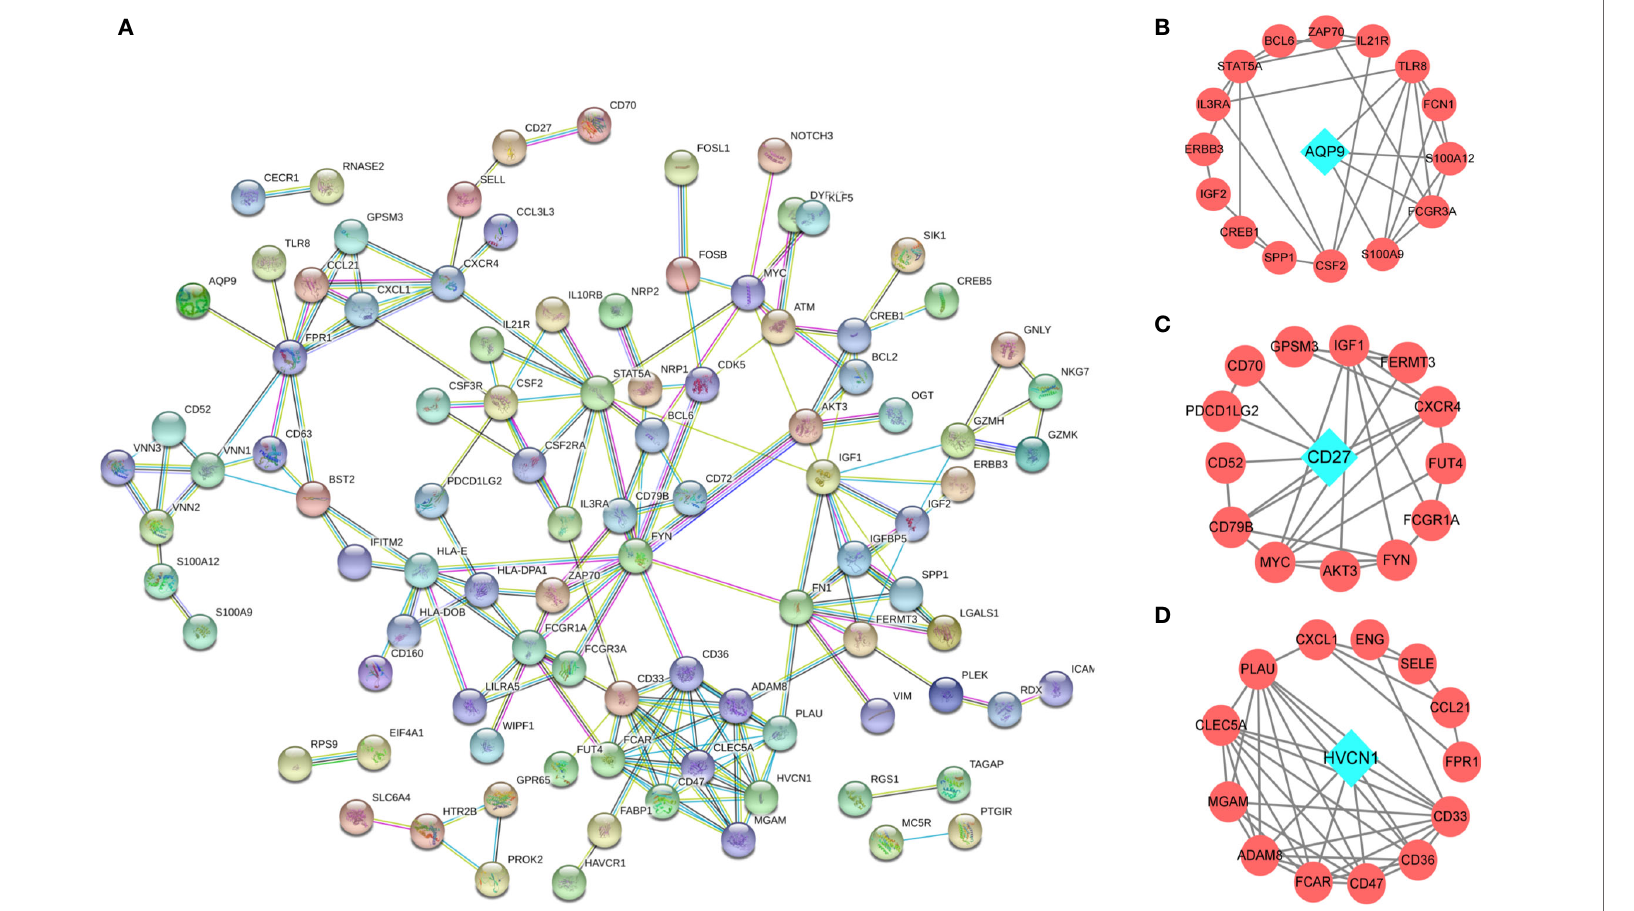
FIGURE 2 | The protein-protein interaction (PPI) network for the DEGs. (A) PPI network for 166 immune-related DEGs, each round node represent a gene; (B – D) Sub-clusters of PPI network, the green diamond shape of node indicated the key gene of